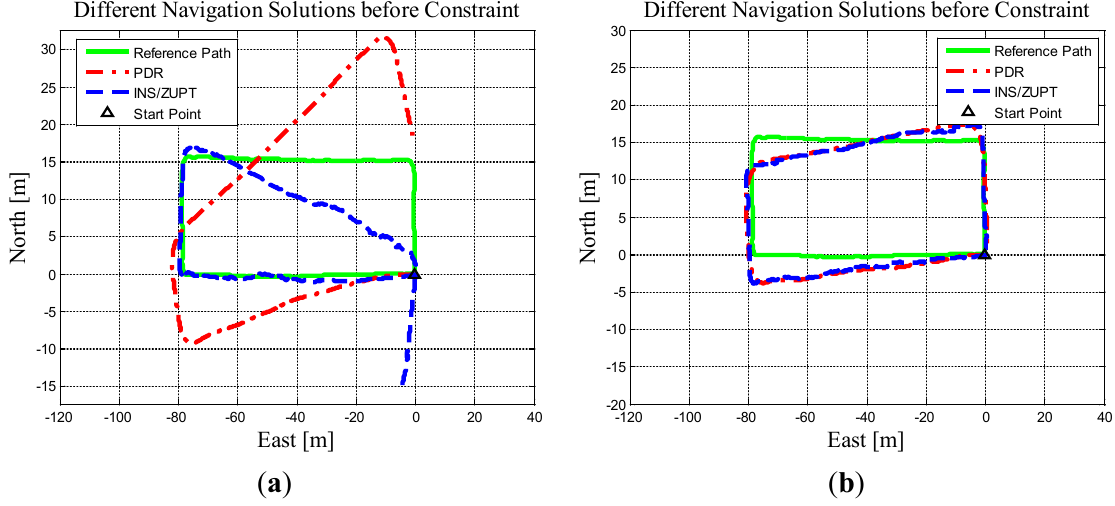
Figure 13. Trajectory VI: Two systems’ navigation solutions. ( a ) Before constraint; ( b ) After